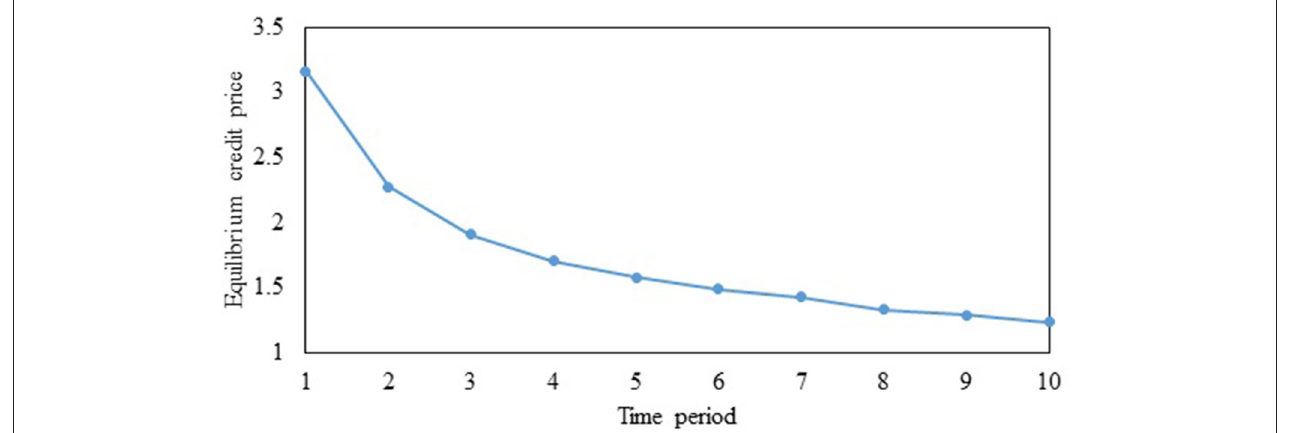
FIGURE 9 | Equilibrium credit prices under value of time heterogeneity, but with the system optimal TCS design assuming value of time homogeneity.